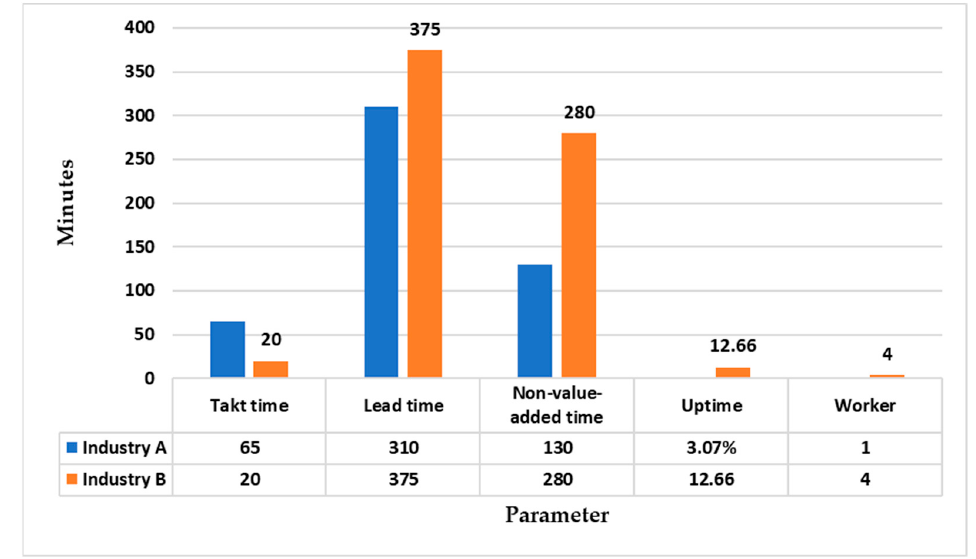
Figure 12. Improvement obtained by the developed methodology in parameters.